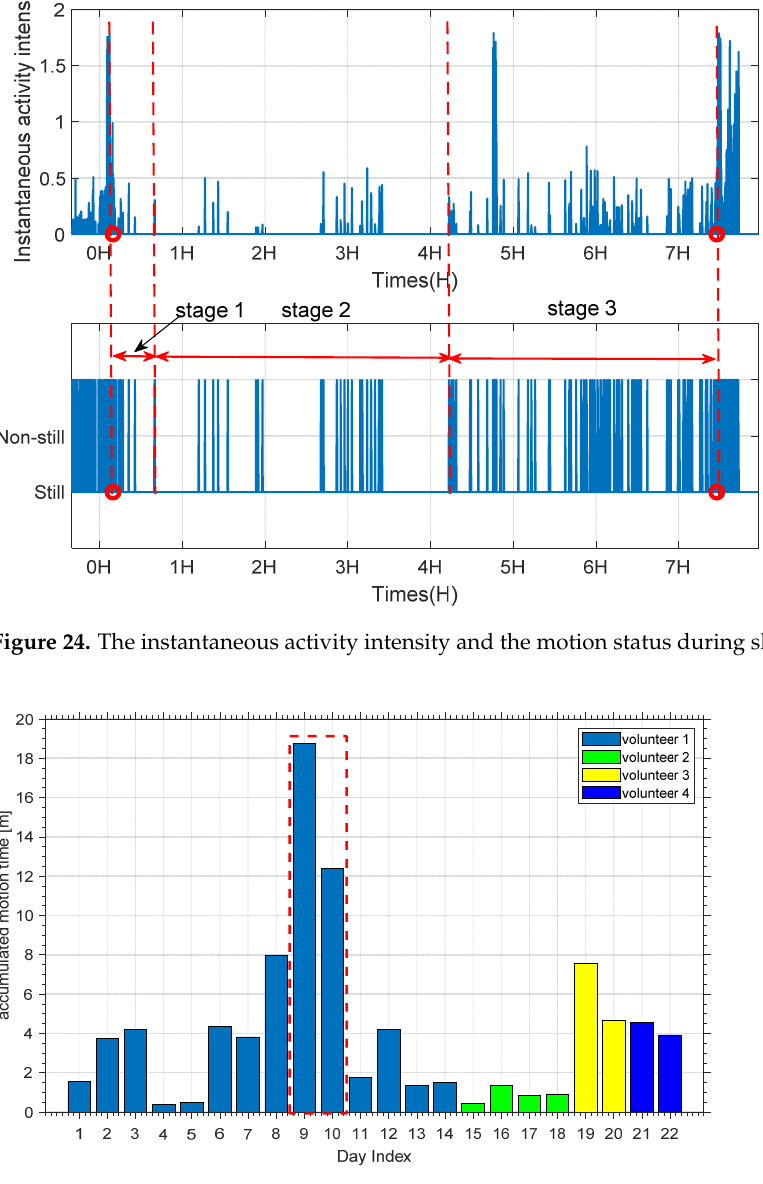
Figure 25. The accumulated motion time during sleep of all the volunteers.